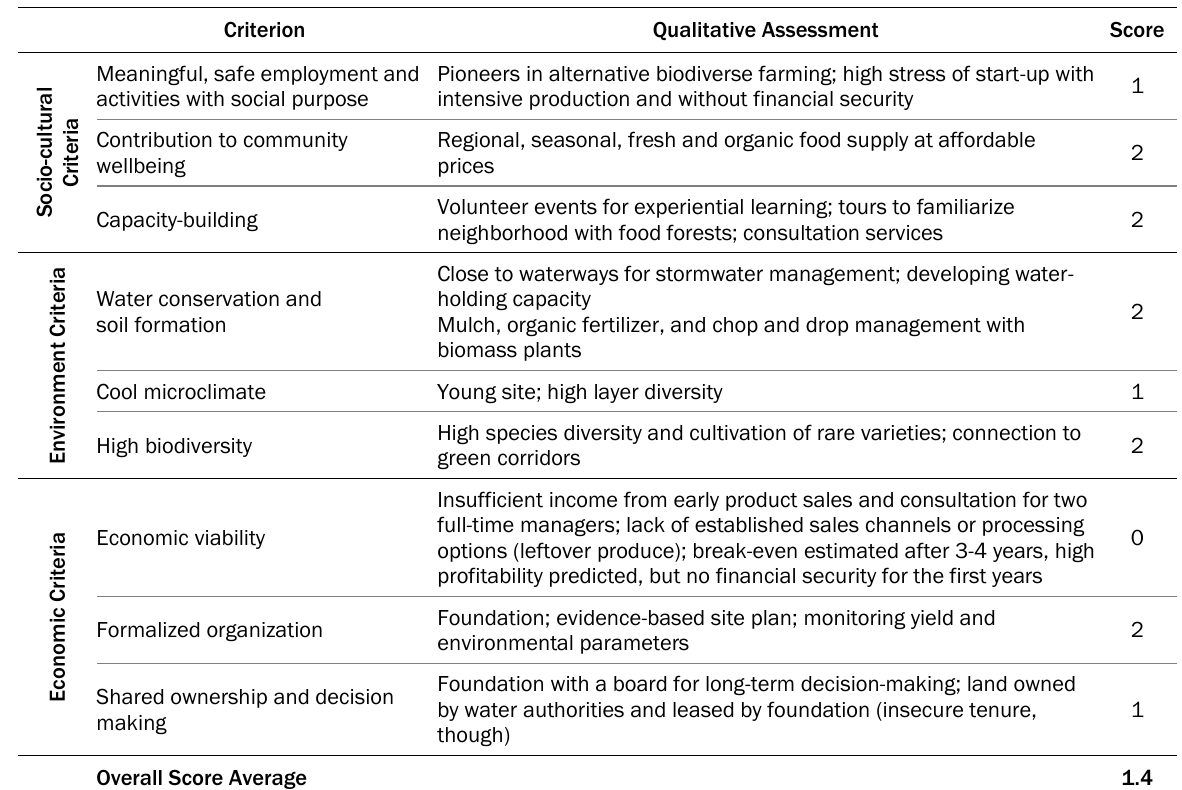
Table 2. Sustainability Performance of Den Food Bosch in 2018 (2=fully met, 1=somewhat met, 0=not met) Applying the Multidimensional Set of Criteria Developed in Albrecht & Wiek (2021)